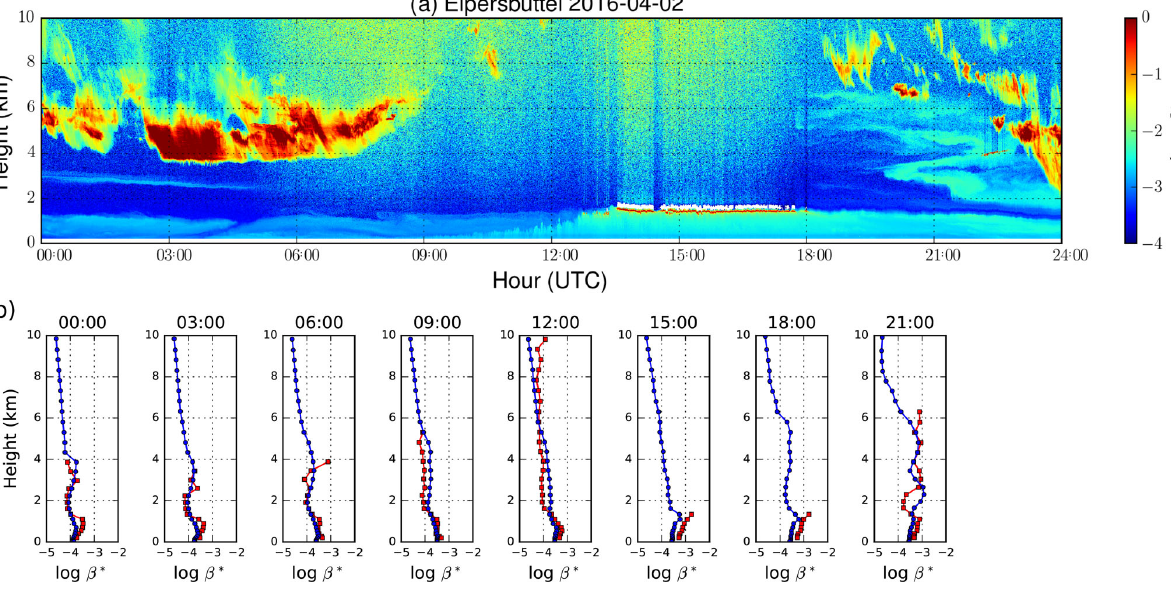
Figure 10. Time series of attenuated backscatter measured by the ceilometer at Elpersbüttel during a dust episode on 2 April 2016 are shown in panel (a) . Attenuated backscatter calculated from model simulations (blue curve) is shown in panel (b) ; ceilometer measurements (red curve) are averaged to model resolution and shown for